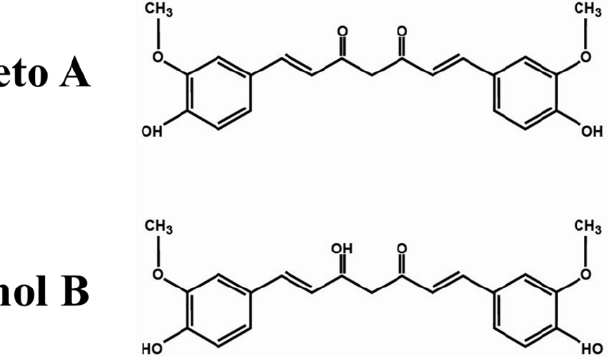
Figure 1. Keto A and enol B forms of curcumin.